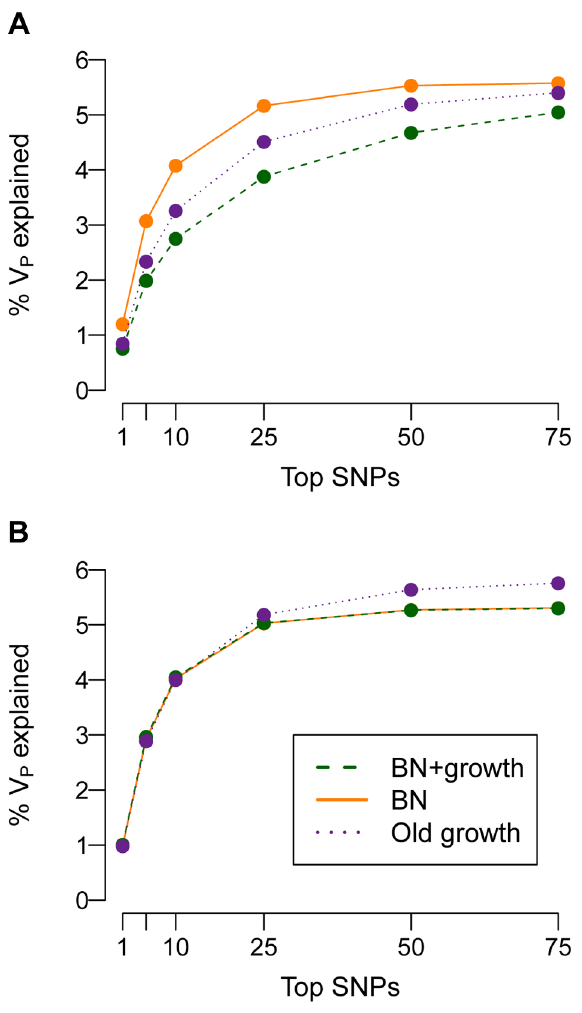
Figure 6. Cumulative distribution of the amount of the phenotypic variance of a trait ( V P ; y -axis) explained by the SNPs that explain the most variance ( x -axis). ( A ) A SNP’s effect on the trait is correlated with its effect on fitness ( t =0.5). Note that the top SNPs that account for the most variance explain less of it in the population that experienced recent growth (green; BN + growth) than in the populations that did not recently expand (orange and purple; BN and Old growth). ( B ) A SNP’s effect on the trait is independent of its ~ 0 : 05 and M =70 kb. effect on fitness ( t =0). Here h 2 C